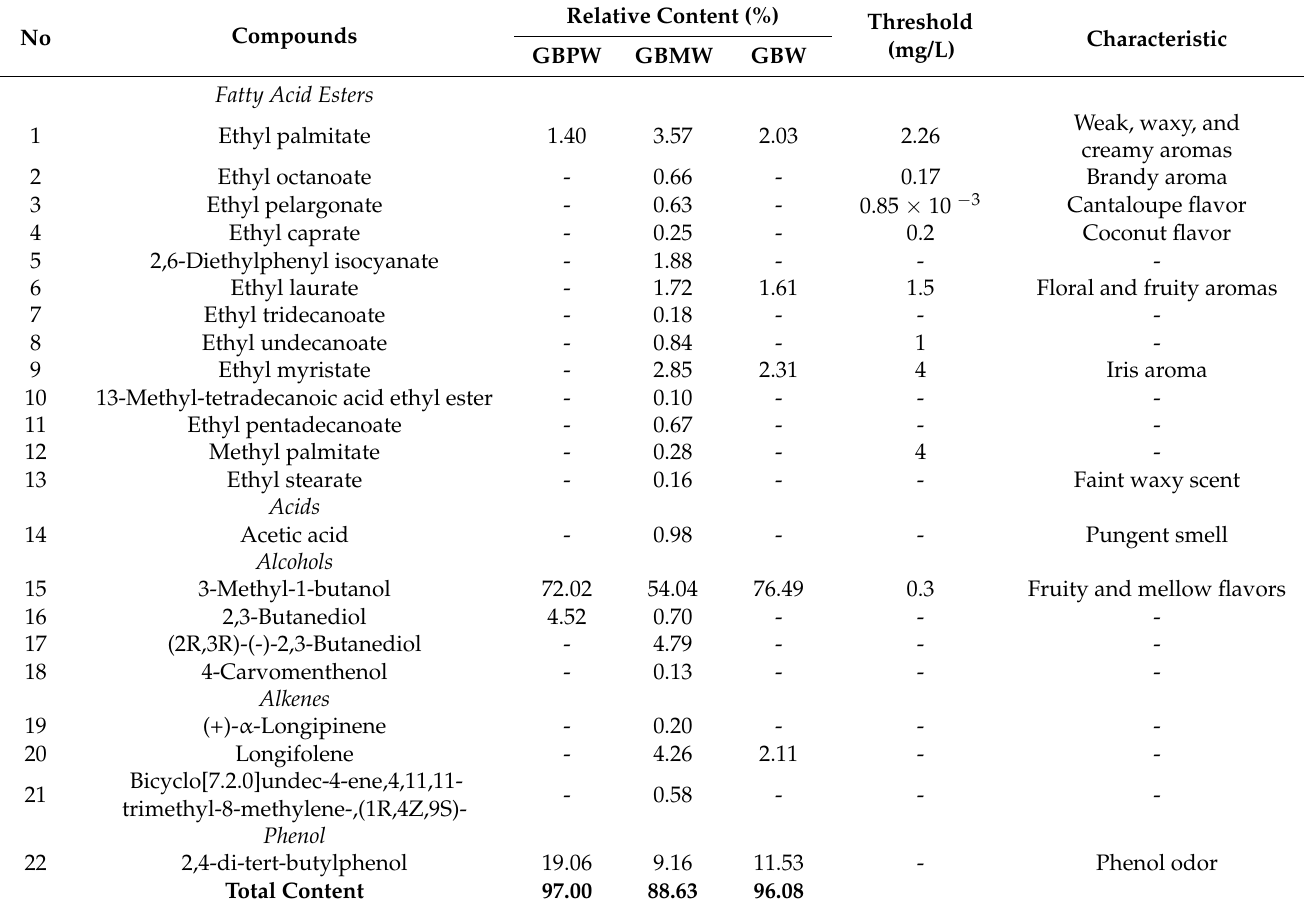
Table 3. Flavor components in green banana peel (GBPW), pulp (GBMW), and whole fruit wine (GBW)